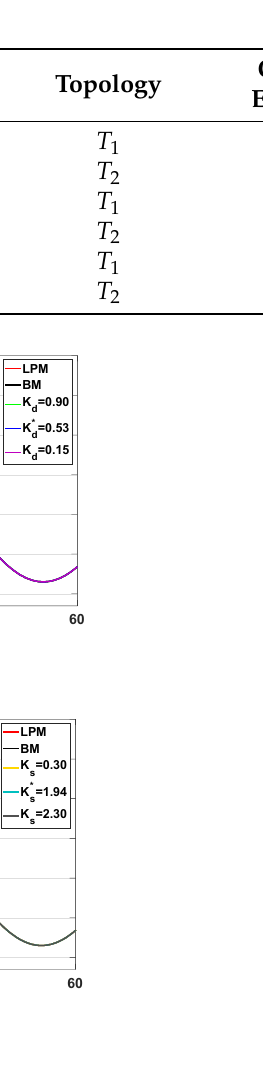
Figure 9. V m ( t ) for the 20-km single-phase TL in scenario 1 for: ( a ) LPM, BM and T 1 and ( b ) LPM, BM and T 2 . Table 4. Transient Peaks (P) and Errors ( (cid:101) (%)) for scenarios 1, 2 and